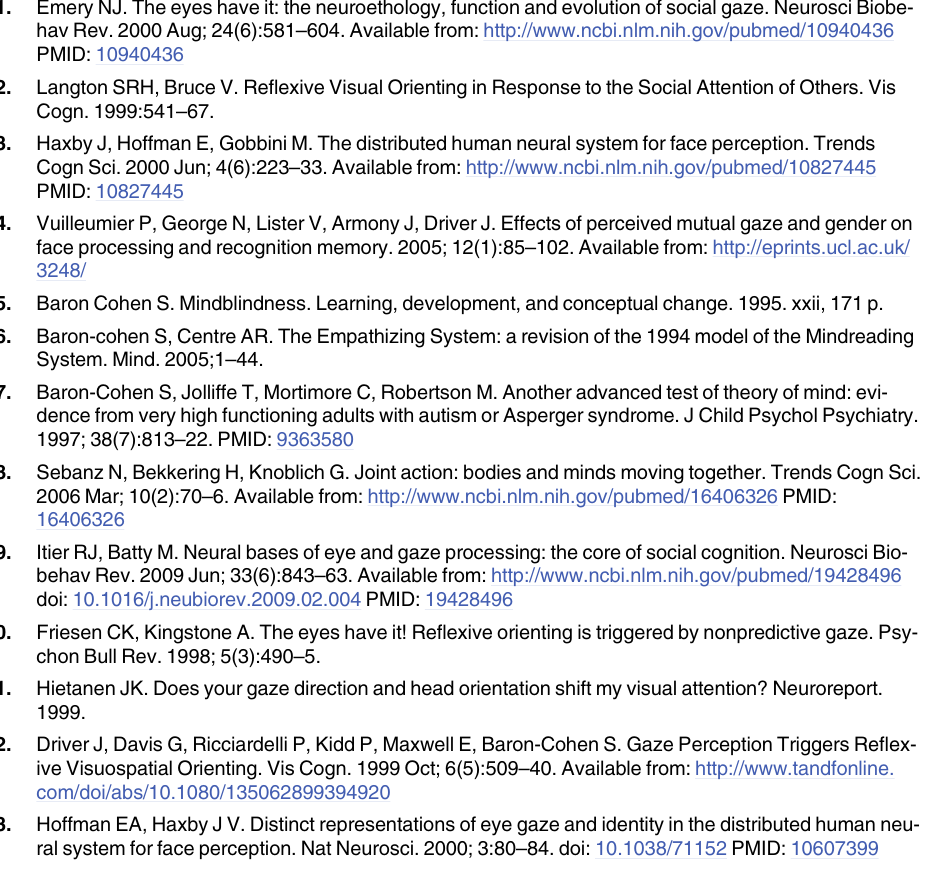
S1 Table. Individual average of median RTs per condition Experiment 1. S2 Table. Individual average of median RTs for neutral validity Experiment 1. S3 Table. Individual average of median RTs per condition Experiment